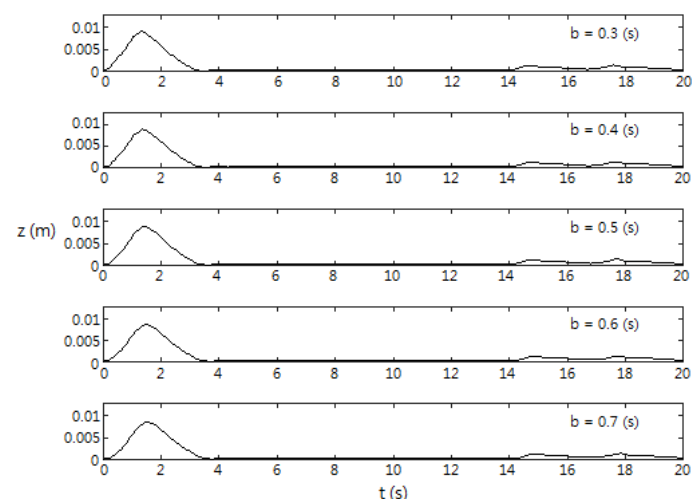
Figure 10. Effects of motion duration b on wave generation by an upward bottom motion: records of free-surface elevation at the hinge for different b values. In all cases, h = 0.05 m, L = 1 m, a = 0.02 m, and θ = 0. Time duration of bottom motion (top to bottom): b = 0.3, 0.4, 0.5, 0.6, 0.7 s.